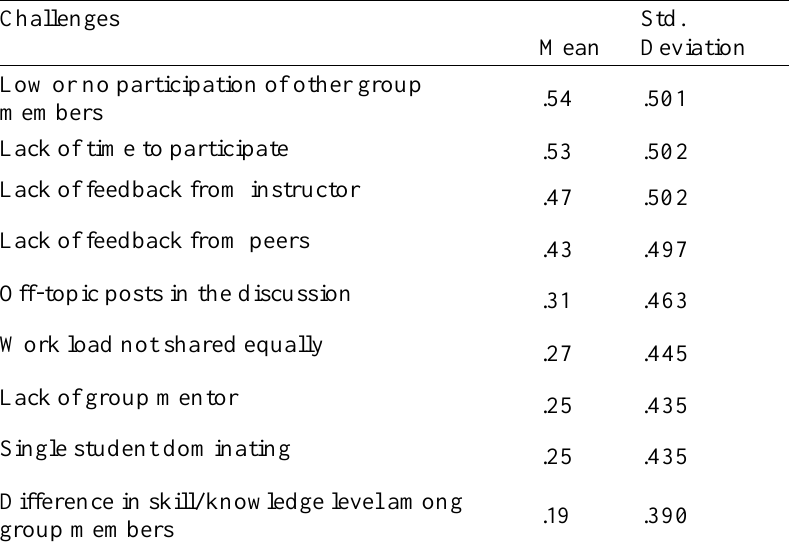
Mean Ranking and Standard Deviation for the Nine Key Challenges as Perceived by the Respondents (N=108) Challenges